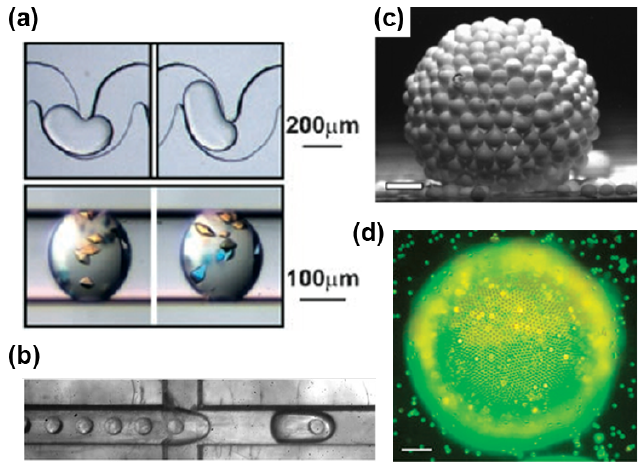
Figure 3. Examples of passive techniques engineered to control particles in microscale laminar flow. Immiscible liquid-liquid flows enable the encapsulation of solids within dispersed droplets and thereby limit the particle-to-wall interactions, shown for ( a ) protein crystals (Reprinted with permission from Reference [67] Copyright 2005 American Chemical Society) and ( b ) polymers (Copyright Wiley-VCH Verlag GmbH & Co. KGaA, reproduced with permission) [39]. Immiscible interfaces also provide lower surface free energy sites for particles to accumulate, thus ( c ) collecting particles at gas-liquid interfaces (scale bar = 400 µm) (Reprinted with permission from Reference [88] Copyright 2006 American Chemical Society)and/or ( d ) creating armored bubbles is possible (scale bar = 60 µm) (Reprinted by permission from Macmillan Publishers Ltd: Nature Materials [90], copyright